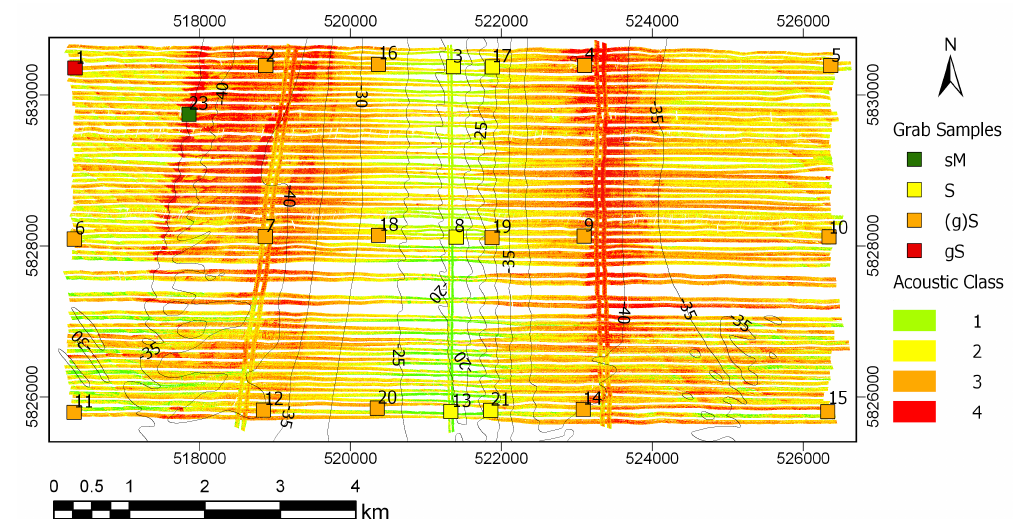
Figure 7. Acoustic classification map of Brown Bank obtained from backscatter data for beams between 25 ◦ and 65 ◦ . Also shown are grab Folk classes with their station numbers. Depth contours (solid black lines) are presented at 5 m intervals.